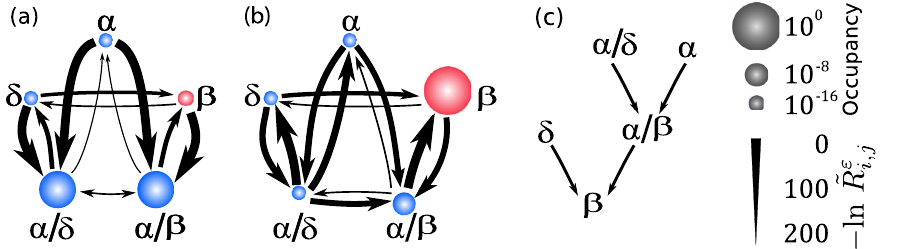
FIG. 3. Controlled stochastic lineage switching in a multidimensional model of HPC differentiation. (a), (b) NESTs of the model for the unmodified parameters (a) and for OLAC applied to optimize the limiting occupancy of the β cell state (red) (b), for ε ¼ 0 . 01 . In both panels, node size indicates the limiting occupancy of the state and edge width indicates the (negative of the) log transition rate. OLAC identifies that only three (out of ten) transcription factors need to be tuned in the model to optimize β -cell occupancy: MafA (increased), Brn4 (decreased), and δ -gene (decreased). (c) Transition hierarchy into the β cell state for the optimized system. Two states ( δ and α = β ) transition directly; two others ( α and α = δ ) require passage through an intermediate state — in this case α = β